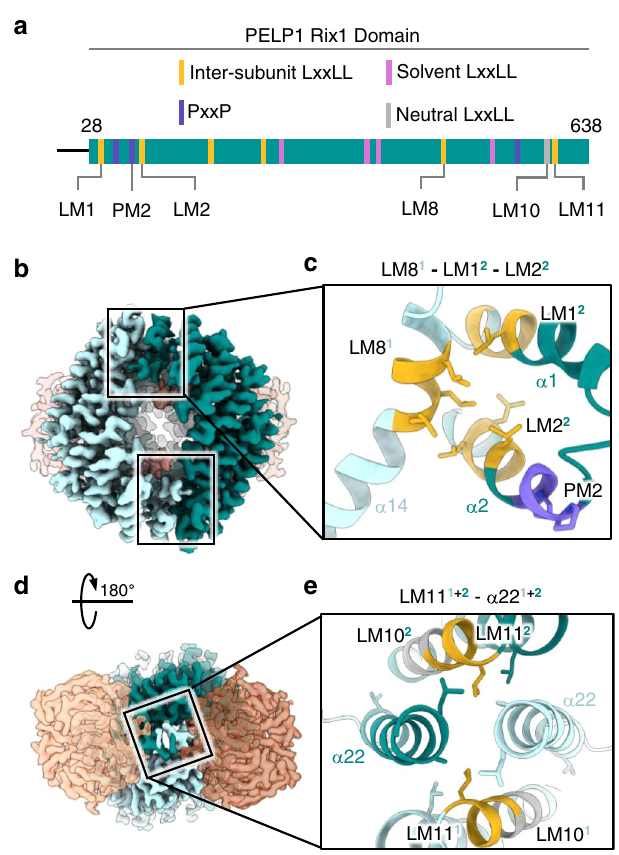
Fig.3|StructuralbasisofPELP1-PELP1dimerization.a Schematicrepresentation of PELP1 ’ s Rix1 domain with localization of LxxLL and PxxP motifs. Speci fi c motifs involved in PELP1 dimerization, or residing close to dimer interfaces, are noted below the schematic. b Bottom view of segmented cryo-EM density showing two symmetric PELP1 dimerization interfaces between LM8 1 -LM1 2 -LM2 2 (superscript denotes speci fi c protomer). c Model zoom of LM8 1 -LM1 2 -LM2 2 dimer interface exhibiting a hydrophobic environment produced by mainly leucine residues from LxxLL motifs. d Top view of cryo-EM density showing a single symmetric PELP1 dimerization interface between LM11 and α -helix 22 of each PELP1 protomer. another hydrophobic interface